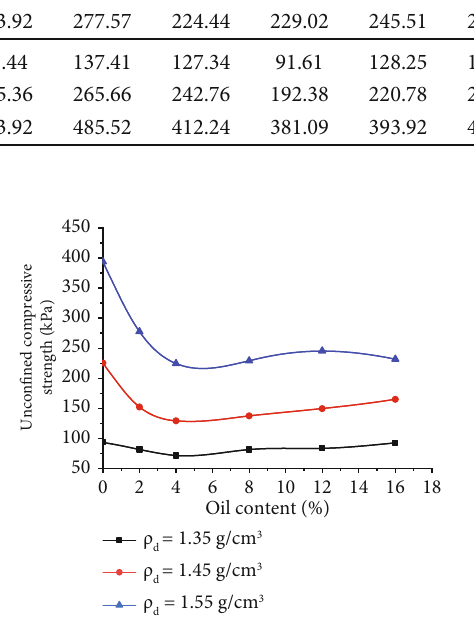
Figure 9: Uncon fi ned compressive strength of diesel-contaminated loess under the fi rst mode of oil contamination.